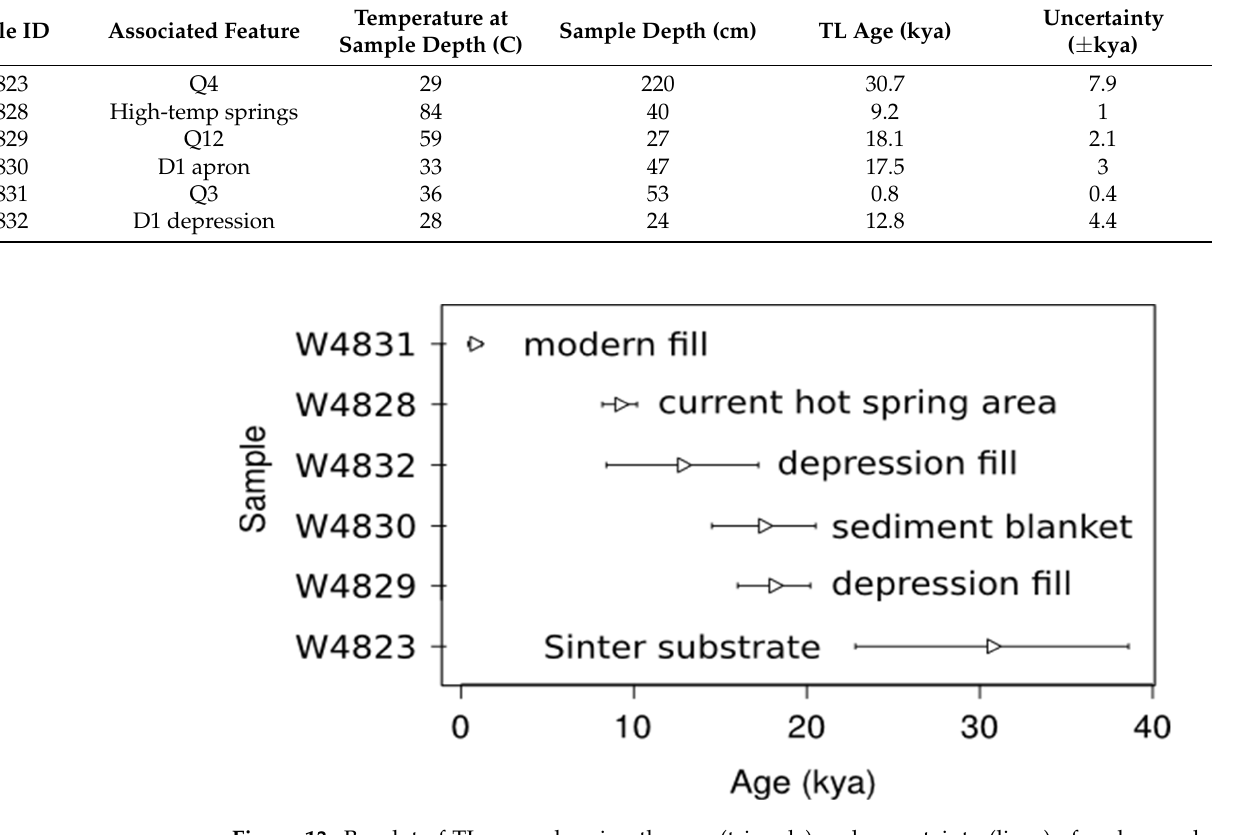
Figure 13. Barplot of TL ages, showing the age (triangle) and uncertainty (lines) of each sample. Material beneath the laminar sinter of Q4 is the oldest dated sample at 30 kya. Well-sorted fine- grained sediment from depressions and blanketing sinter aprons range in age from 18–12 kya. The age of the sediment from near the current high-temperature springs is ~9 kya. The youngest TL date is from poorly sorted sand in feature Q3.